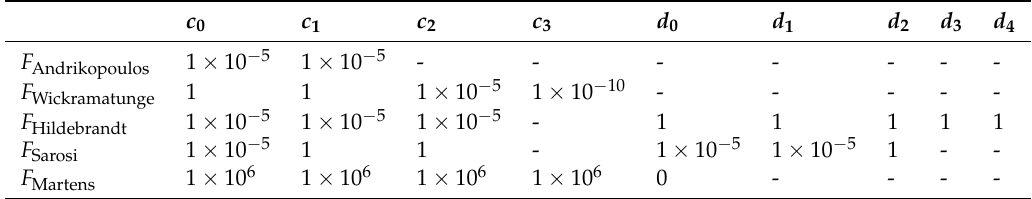
Table 1. Start points of parameter estimation for all models without units.